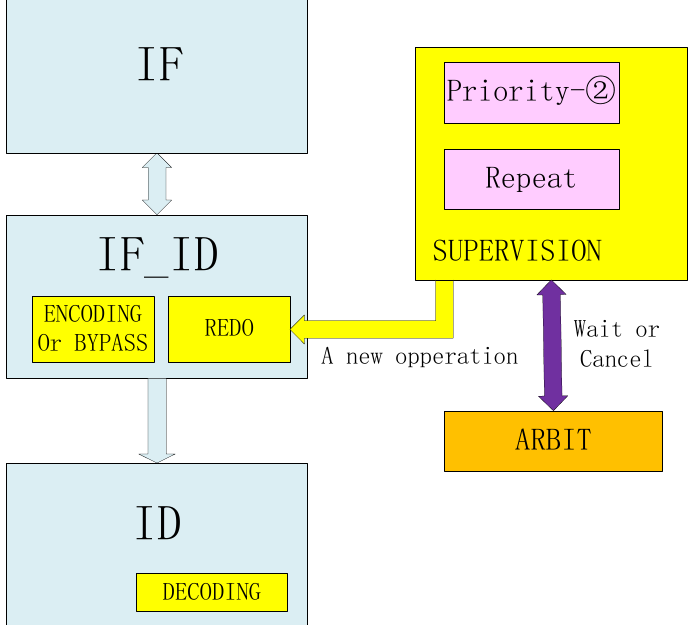
Figure 10. Fetching-decoding rollback process. After the data from the fetching module enters the timing logic, the data without error is sent to the decoding module. If there is an exception, the REDO operation will be executed at this stage to return the original data. The REDO operation is arbitrated by the ARBIT module, and then the SUPERVISION module is notified to give feedback.